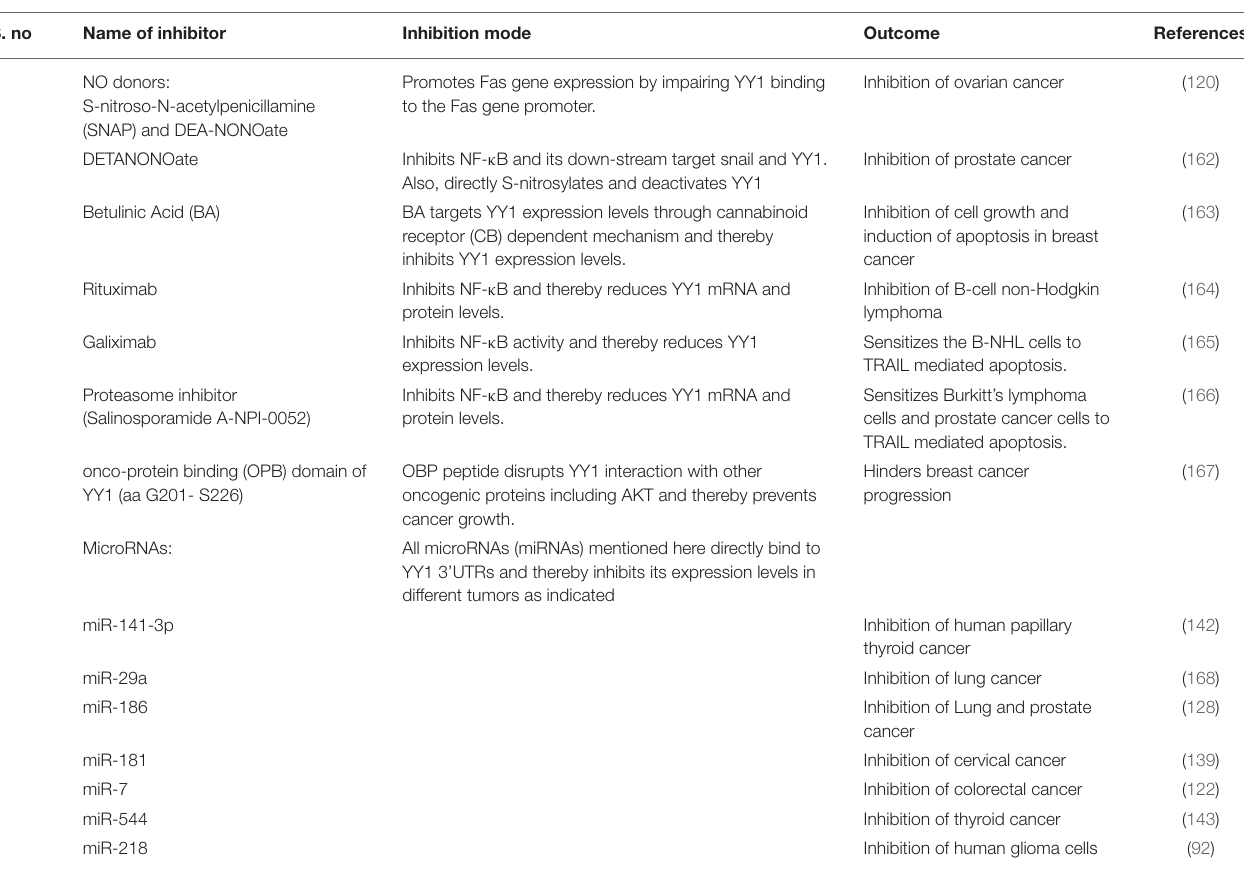
TABLE 5 | YY1 reported inhibitors and their inhibition mechanism in different